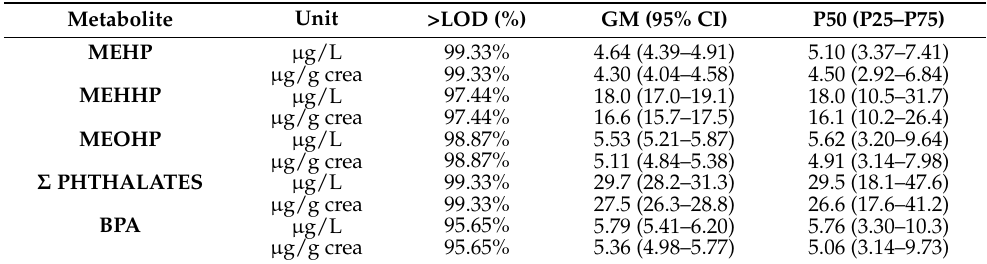
Table 2. DEHP metabolite and BPA levels in urine samples of 898 Italian women. In the table are reported the percentage of the samples above the limit of detection (LOD), the geometric mean (GM) with the 95% confidence interval (CI), and the median (P50) with the interquartile range (P25–P75). For each metabolite, the first row refers to the unadjusted concentration in urine ( µ g/L) and the second row to the creatinine-adjusted concentration ( µ